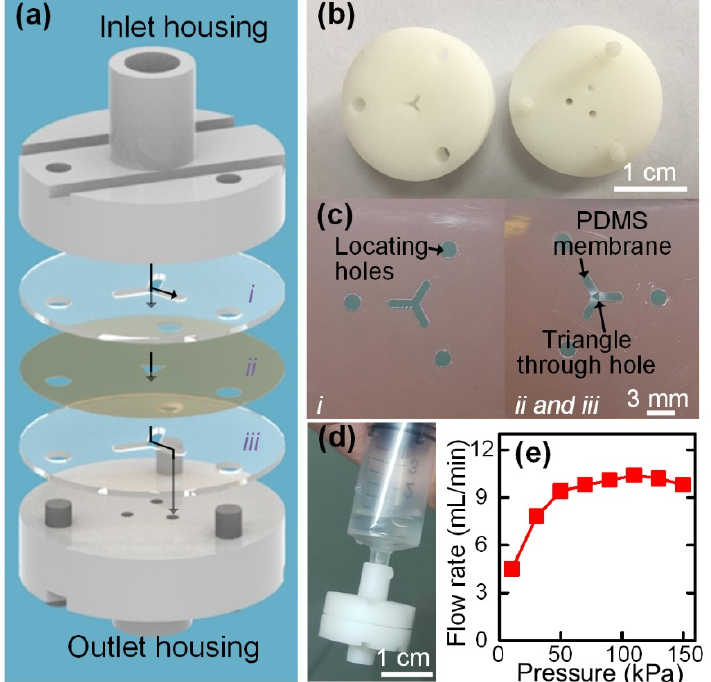
Figure 4. ( a ) Schematic diagram of the syringe-tip flow stabilizer containing an inlet housing, a flow stabilizing actuator (i, ii, and iii), and an outlet housing. The arrows in this figure illustrated the flow paths of one parallel flow regulator. ( b ) Photographs of the inlet and outlet housings that were fabricated by 3D printing. ( c ) Fabricated parts (i, ii, and iii) for assembling the flow- stabilizing actuator. Three parallel flow regulators were integrated in the syringe-tip flow stabilizer. ( d ) Photograph showing the prototype of the syringe-tip flow stabilizer. ( e ) Output flow rates of the syringe-tip flow stabilizer under different applied